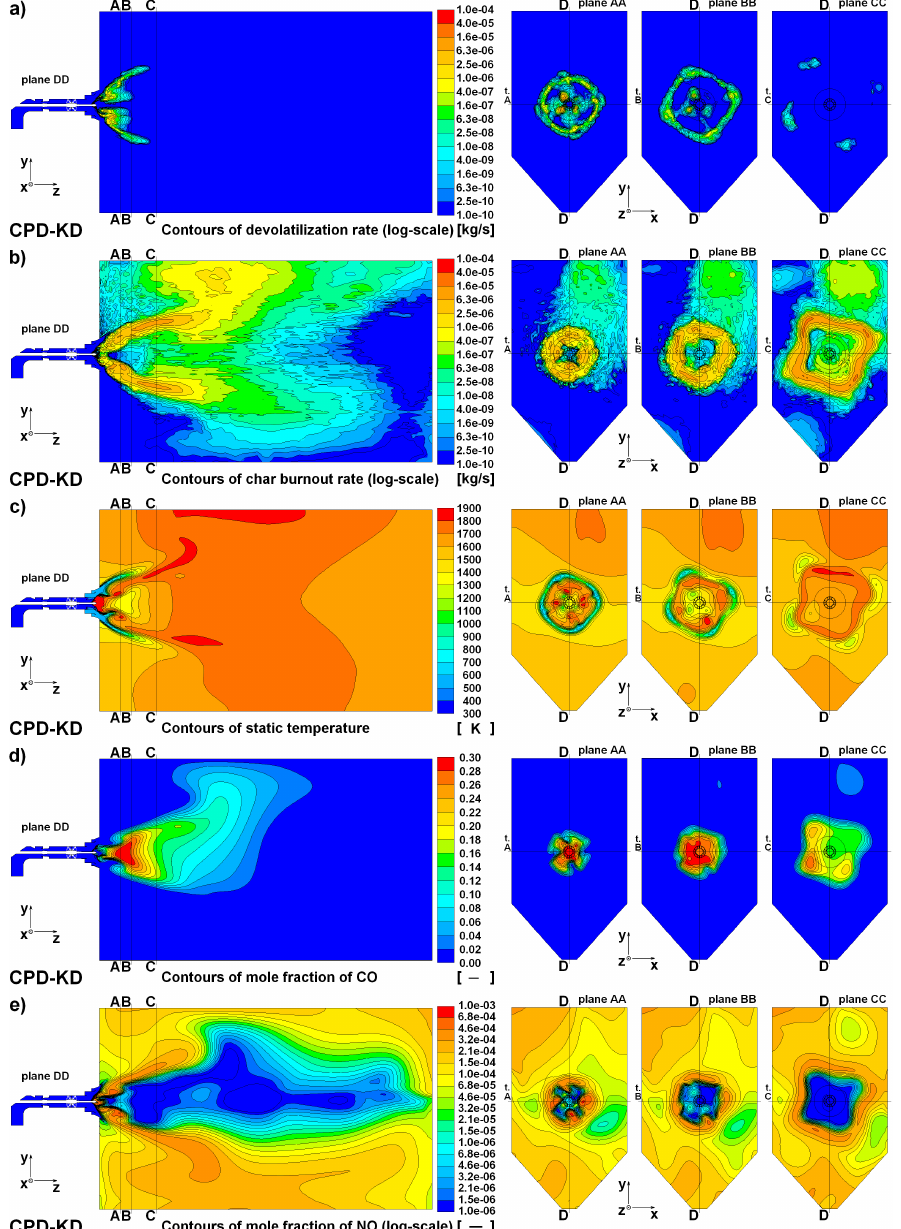
Figure 8. Results obtained by means of the CPD-KD model. ( a ) Devolatilization rate; ( b ) char burnout rate; ( c ) static temperature; ( d ) mole fraction of CO; and ( e ) mole fraction of